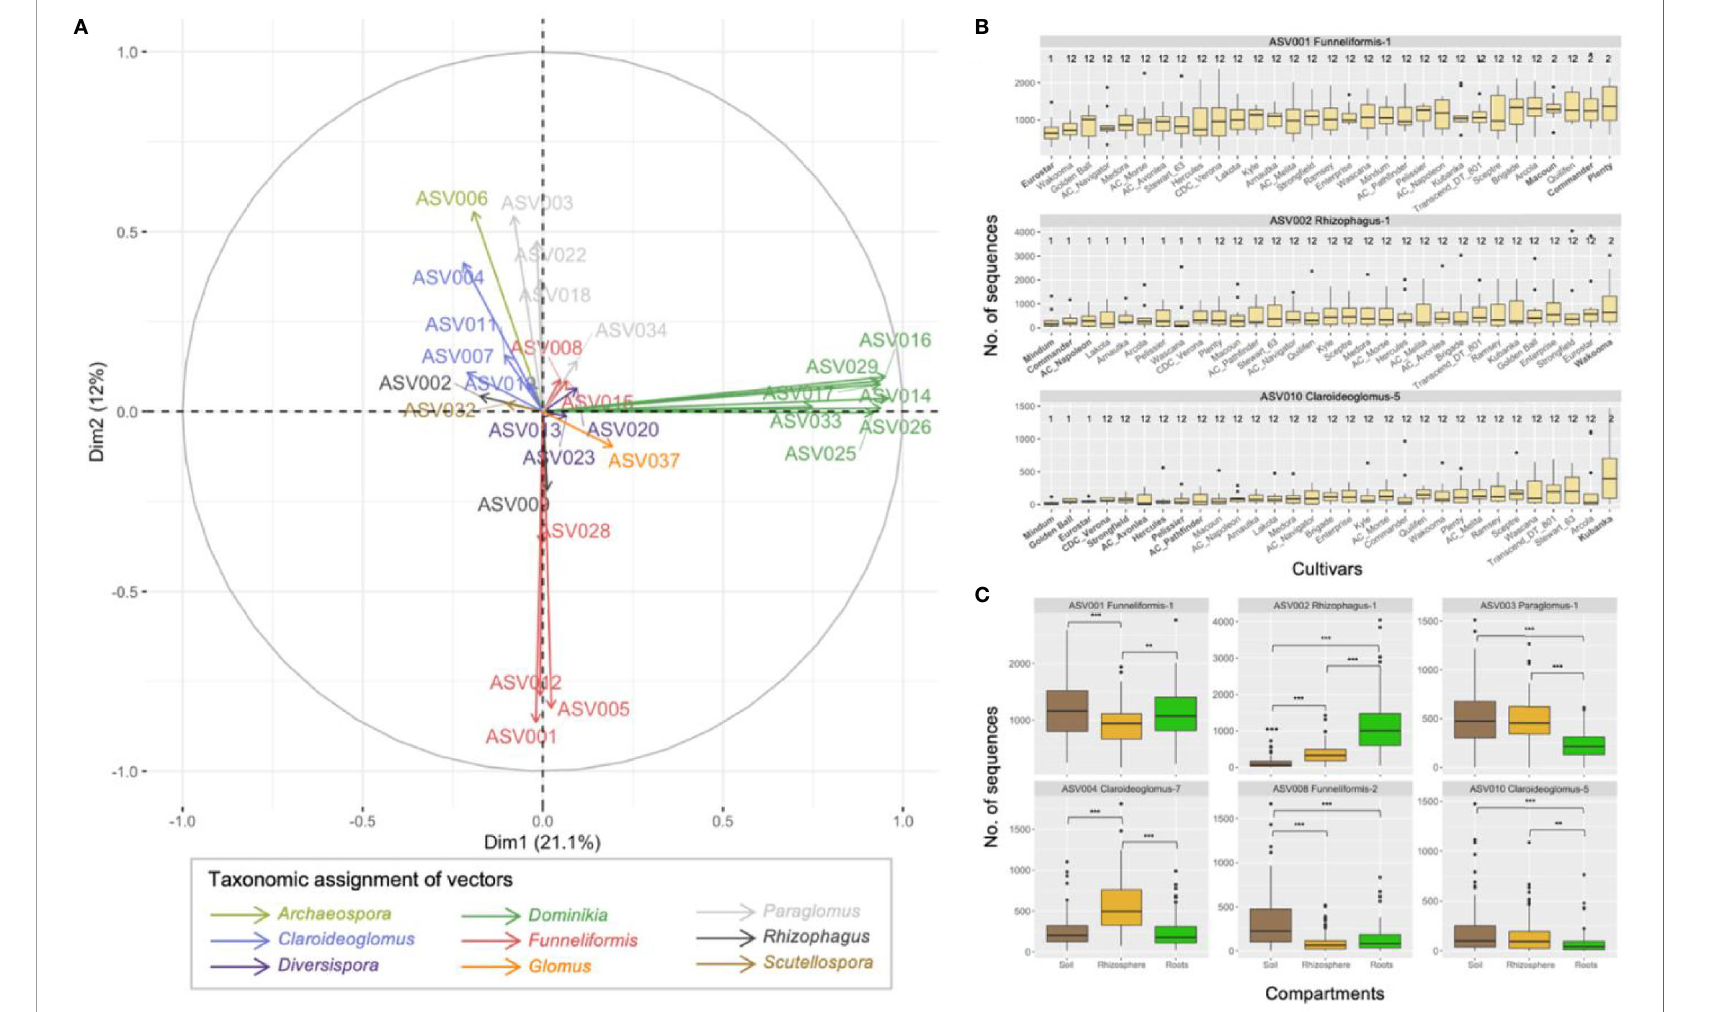
FIGURE 5 | (A) Principal component analyses on 29 ASVs with non-zero values in > 50% of the samples across the three compartments (category ASV 50+ ). The fi rst two principal components explained 33.1% of variance. (B) Boxplots showing the abundance of the three ASVs for which signi fi cant differences were recorded between the pairwise comparisons of the 31 cultivars of durum wheat. Boxplots with a different number indicate signi fi cant differences between cultivars ( p < 0.05). Boxplots were ordered by increasing mean abundance. (C) Boxplots showing the abundance of the six ASVs for which the signi fi cant differences were found between soil, rhizosphere and root compartments. Non-signi fi cant differences are not shown, ** and *** indicate p values < 0.01 and < 0.001,